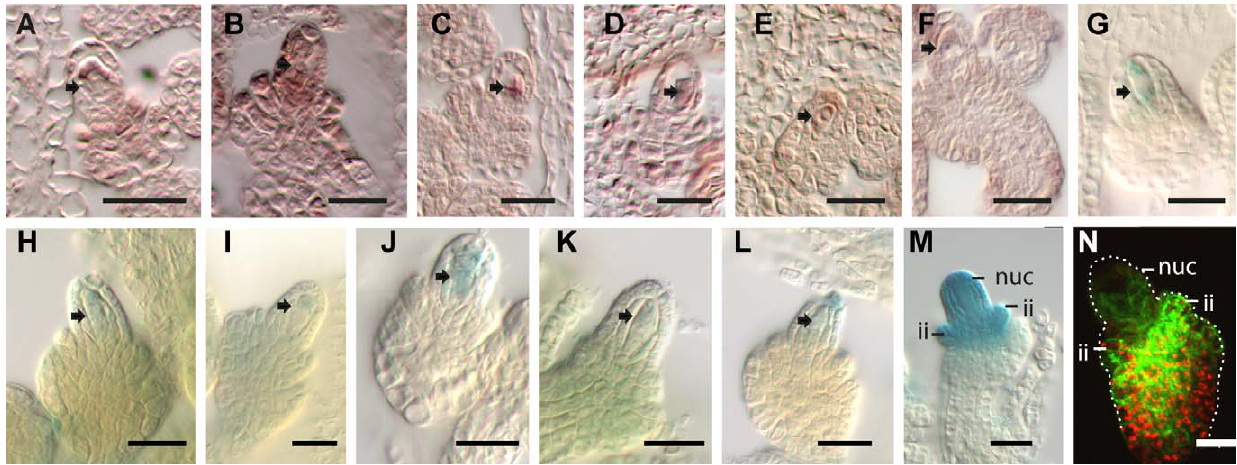
Figure 2. Independent data validation. Data validation for genes preferentially expressed in the MMC (A–L) or expressed in the nucellus tissues (M–N). Scale bars are 20 m m, arrows point towards the MMC, ii (inner integuments), nuc (nucellus). (A–F) In situ hybridizations with antisense probes for AT3G14700 , encoding a SART-1 family protein (A) AT2G30940 , a gene encoding a protein kinase (B), the transcription factor gene AT1G31150 (C), AT2G29210 coding for a splicing factor PWI domain-containing protein (D), PUMILIO23 ( PUM23 , AT1G72320 ) (E), and AT5G23080 encoding TOUGH (TGH), which interacts with TATA-box binding protein 2 (F). (G–J) GUS staining of plant lines expressing translational fusions of the putative promoter regions of AT1G11270 encoding an F-box and associated interaction domains containing protein (G), AT3G19510 encoding HAT3.1 that belongs to the family of PHD-finger homeodomain proteins (I), AT3G21175 encoding GATA transcription factor 24 (H), and AT2G24500 coding for the C2H2 zinc finger protein FZF (J) with the E. coli uidA gene. (K, L) GUS staining of ET4022 and ET7943 with the enhancer trap element inserted in the genomic regions of AT1G31240 and AT1G80440 , encoding a bromodomain transcription factor and a galactose oxidase/kelch repeat superfamily protein, respectively. (M) GUS staining with a line expressing the E. coli uidA gene under control of the PUM12 promoter [22]. (N) GFP signal observed in lines carrying the pABCB19:ABCB19-GFP construct reporting expression of an ATP-binding cassette (ABC) transporter [25].